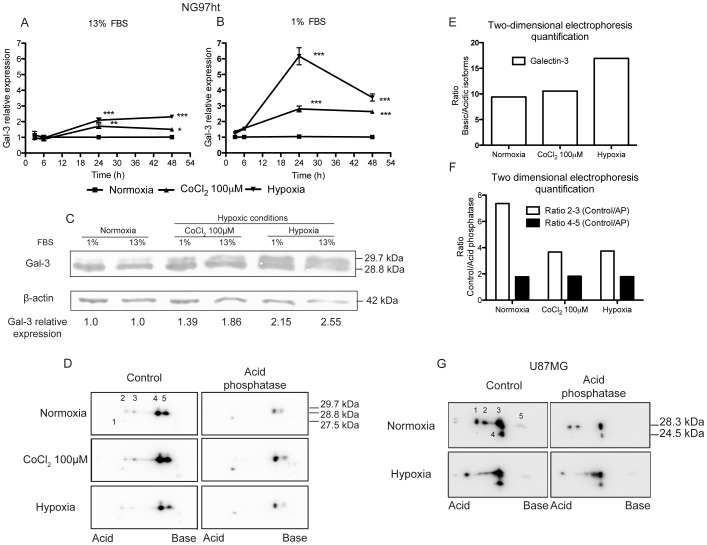
Gal-3 is upregulated in hypoxia in NG97ht cells.Analysis of gal-3 by qRT-PCR and western blot in NG97ht cells exposed to normoxia, CoCl2 and hypoxia in complete or serum-deprived medium. A/B. qRT-PCR demonstrated gal-3 mRNA upregulation after 24 h of exposure either in complete (A) or serum-deprived medium (B) in cells exposed to CoCl2 and hypoxia compared to normoxia. β-actin was used as normalizer. Representative experiment performed at least in three independent assays and data are presented as mean±SEM. *p<0.05; **p<0.01; ***p<0.001. C. Gal-3 protein accumulated after 48 h, in CoCl2 and hypoxia both in complete and serum-deprived medium. Two electrophoretic forms of gal-3, 28.8 kDa and 29.7 kDa, were observed. D. NG97ht cell protein extracts derived from cells exposed to normoxia, CoCl2 and hypoxia in deprived medium for 48 h were submitted to treatment with acid phosphatase (AP) 100 µg/mL and analyzed by two-dimensional gel electrophoresis. Five main forms (1 to 5) were detected in the NG97ht cell line with their isoelectric point (IP) ranging from 8.00 to 9.33 and molecular sizes from 27.5 and 29.7 kDa. Spots 4 and 5 display each two forms of same IP, but different molecular sizes. E. The quantification between isoforms 4–5 (basic) and 2–3 (acidic) demonstrated increase in the first mainly in hypoxia when compared to normoxia. F. In the treatment of the protein extracts with AP, there was a decrease in isoforms 2 and 3 compared to control samples mainly in cells exposed to normoxia. Isoforms 4–5 did not demonstrate changes between normoxia, CoCl2 and hypoxia. G. U87MG protein extracts derived from cells exposed to normoxia and hypoxia in deprived medium for 48 h also demonstrated differences in two-dimensional gel electrophoresis, showing five forms (1 to 5) with IP ranging from 7 to 9 and molecular sizes from 28.3 to 24.5 kDa. Treatment of protein extracts with AP resulted in the IP modification in gal-3 in normoxia.